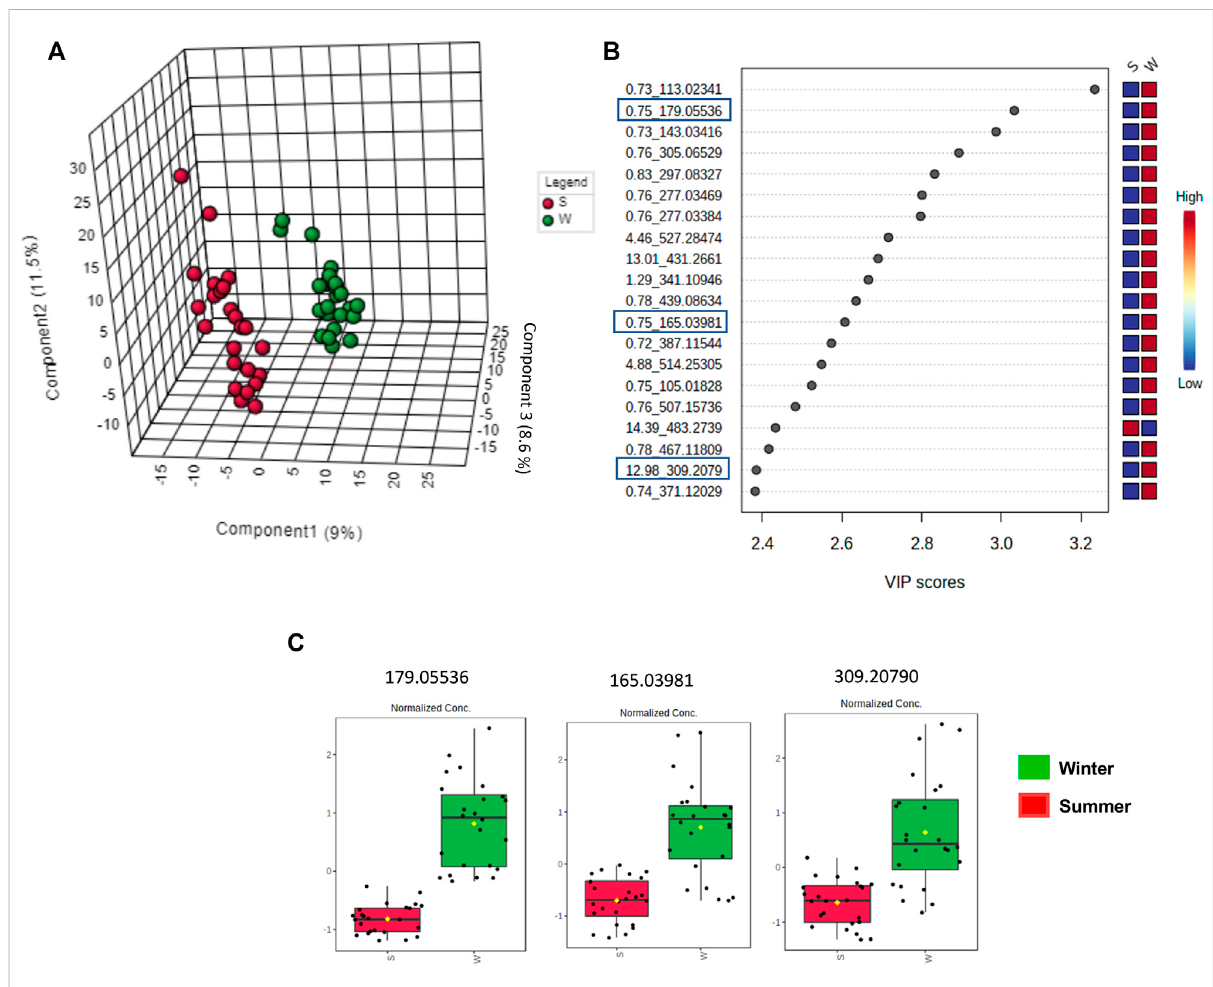
FIGURE 10 Multivariate analysis from LC-HRMS data of V. album mother tinctures in negative ESI mode. Discrimination of the samples in relation to V. album season harvesting. (A) PLS-DA 3D score plot. (B) VIP scores. (C) Box plot graphs of the annotated metabolites (VIP) responsible for discriminating winter (green) and summer (red) samples. Blue rectangles: annotated